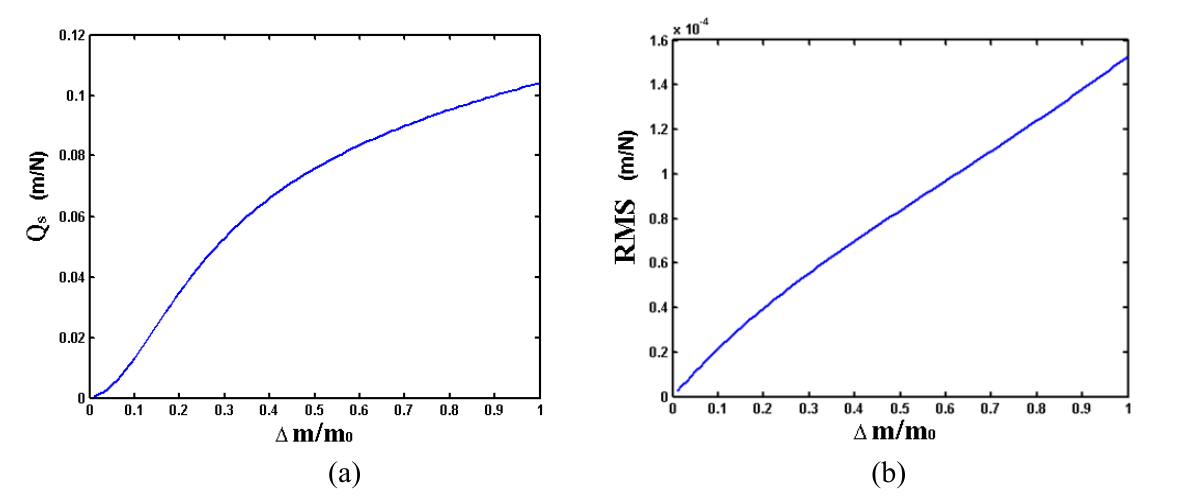
and RMS as a function of mass change. s